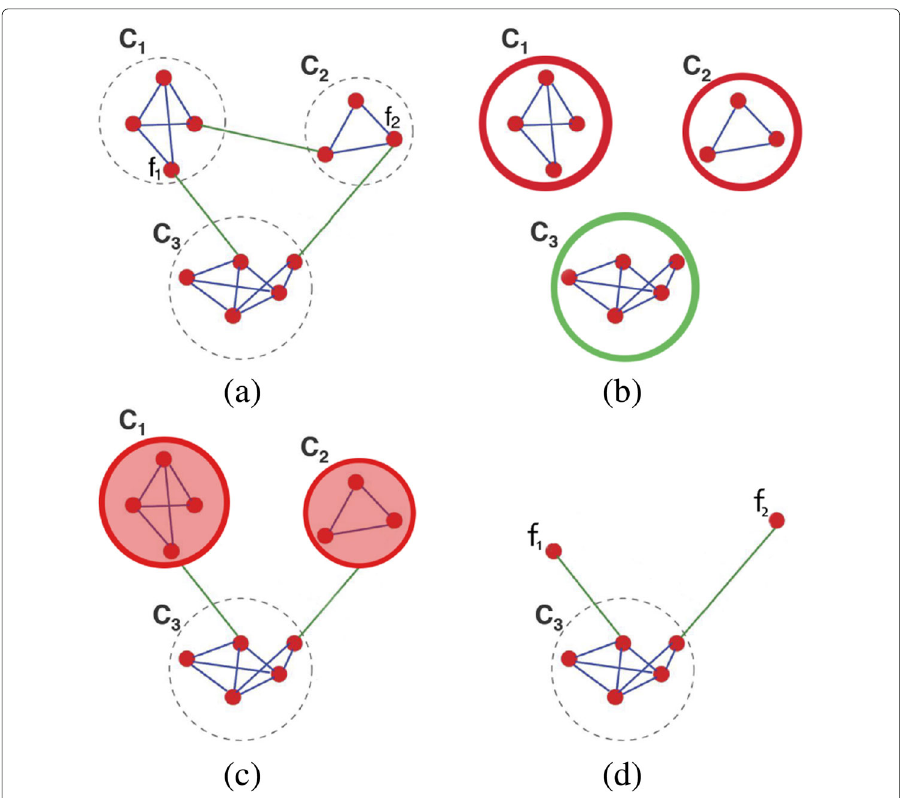
Fig. 5 Example of communities and inter-community connectivity: ( a ) three connected communities; ( b ) IC-SIDL scenario for community C 3 ; ( c ) CC-SIDL scenario for community C 3 ; ( d ) IFC-SIDL scenario for community C